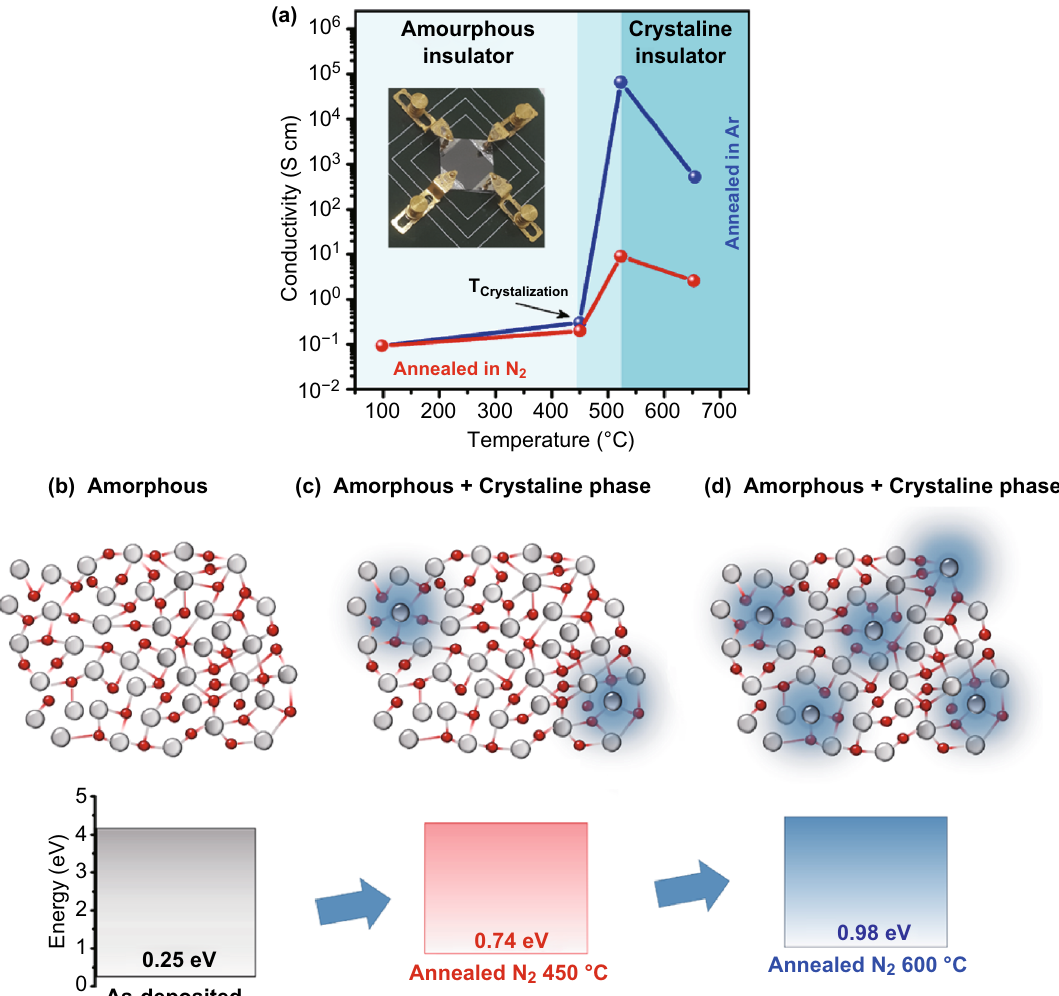
Fig. 3 The results of electrical conductivity measurements and graphical scheme of phase transformation of gallium oxide film during RTA treatment and their XPS measurements. a Conductivity variation of gallium oxide thin films after RTA in Ar and N 2 atmosphere. The conductiv- ity was measured after quenching of samples from high temperatures. b – d The phase transformation in gallium oxide films during RTA treat- ment. The as-deposited films are amorphous until the crystallization temperature at which the nucleation of crystalline stoichiometric Ga 2 O 3 nucleus sites occurs [10]. It is accompanied by the increase in Ga excess in remained amorphous phase and the evolution of conductivity of thin